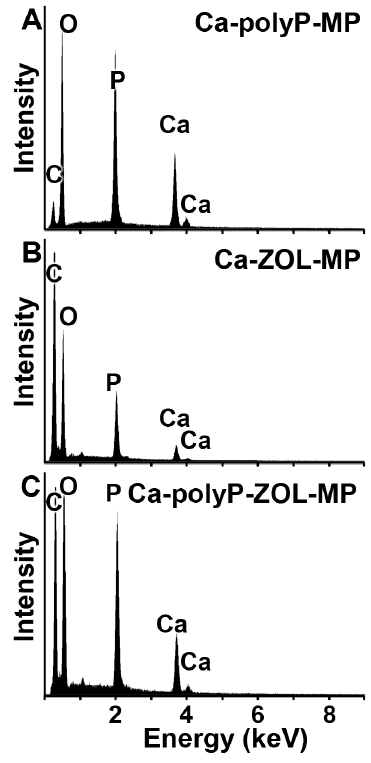
Figure 2. EDX spectra for ( A ) “Ca-polyP-MP”, ( B ) “Ca-ZOL-MP”, and ( C ) “Ca-polyP-ZOL-MP”. The respective signals for the different atoms are marked. EDX, energy dispersive X-ray.